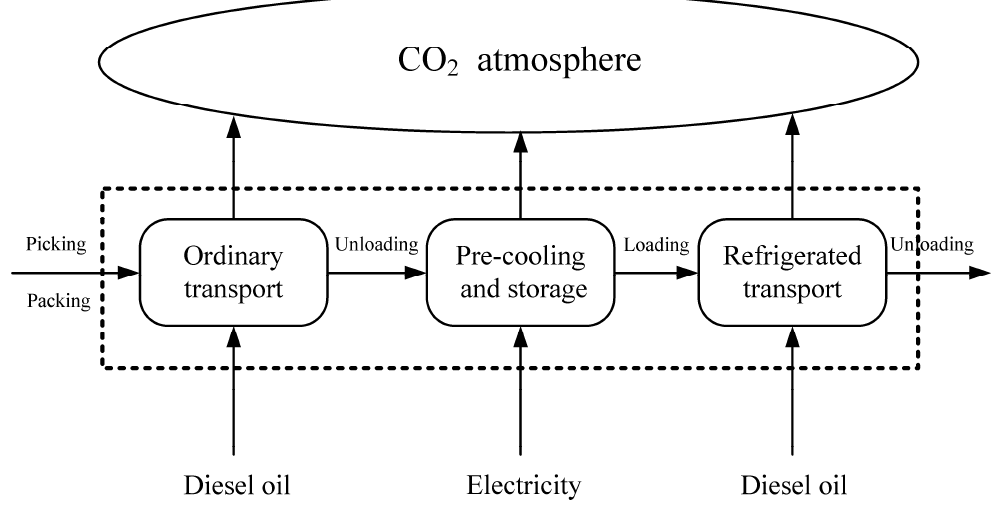
Figure 1. System boundary of table grapes cold chain.